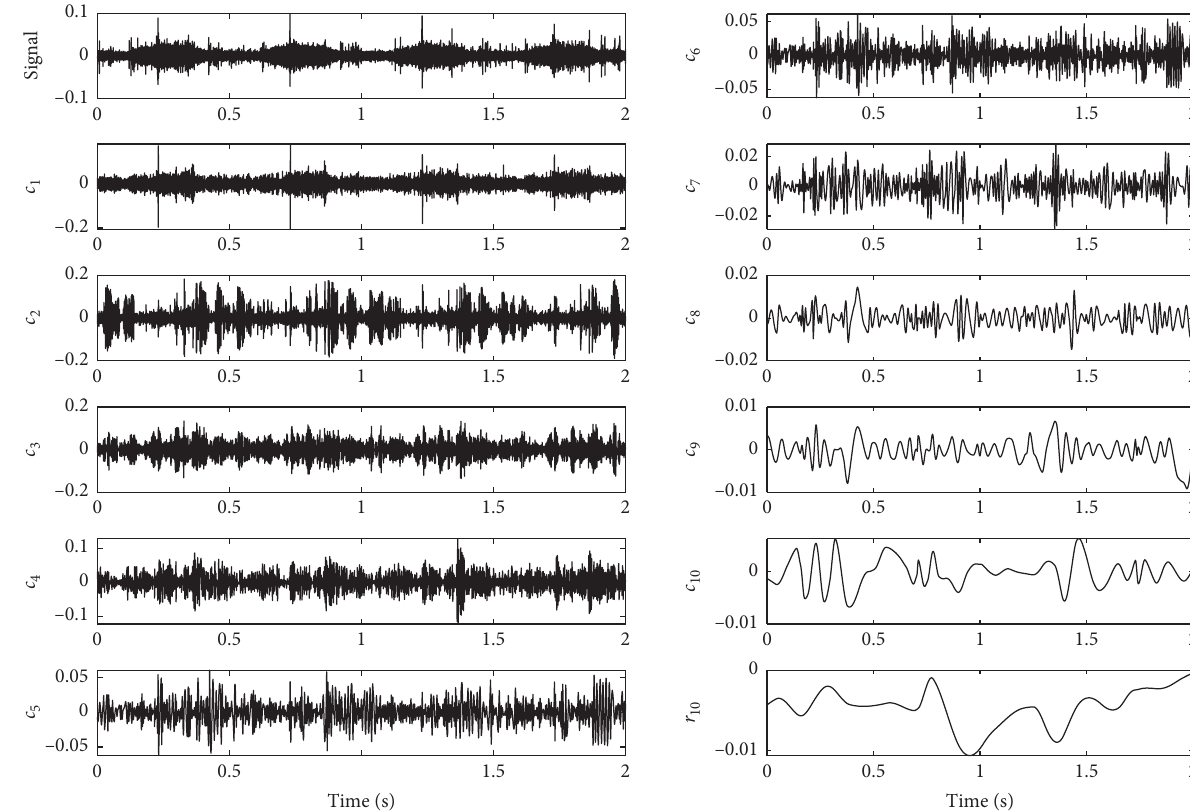
Figure 5: EEMD decomposition results of friction vibration signals in the dry friction.